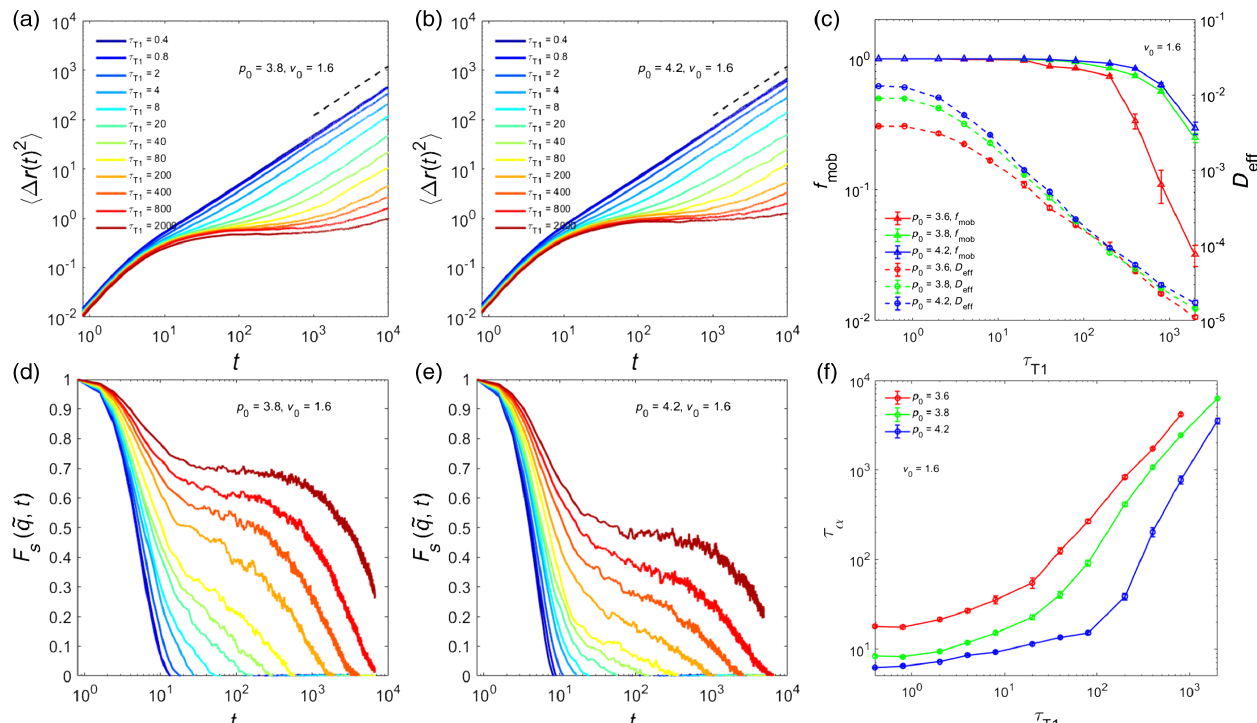
FIG. 10. Here, we show normalized probability distribution functions of measured waiting times τ w between successive T1 events involving individual cells at different v 0 and two different τ broader with heavy power-law tails, while they are always quite narrow and without heavy tails for large τ legends shown in the